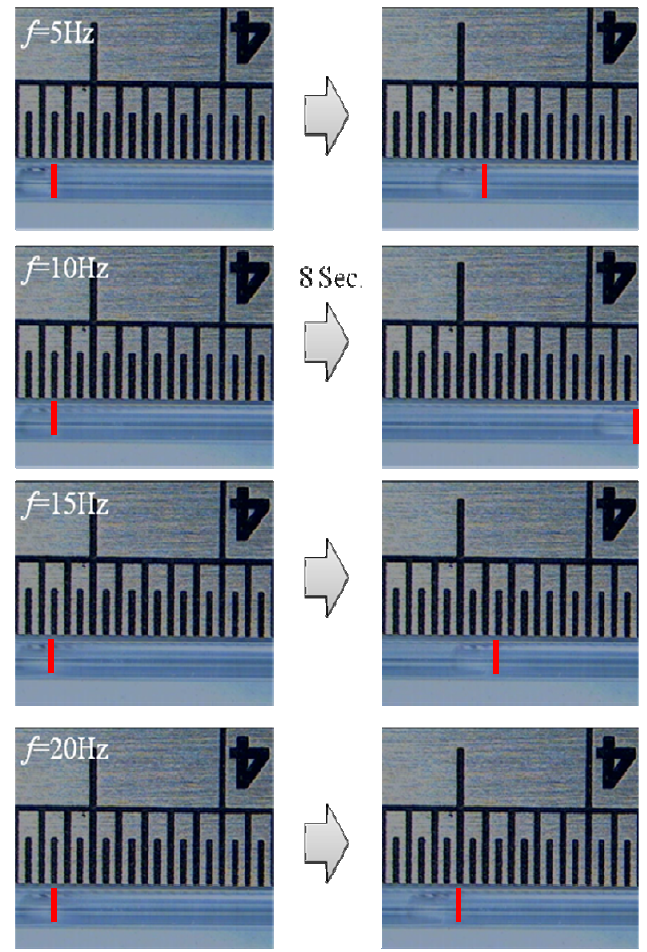
Figure 11. The bubble moving positions at different frequencies with an expansion valve = 30° and θ = 120° and a driving voltage of 150 angles of θ 1 2